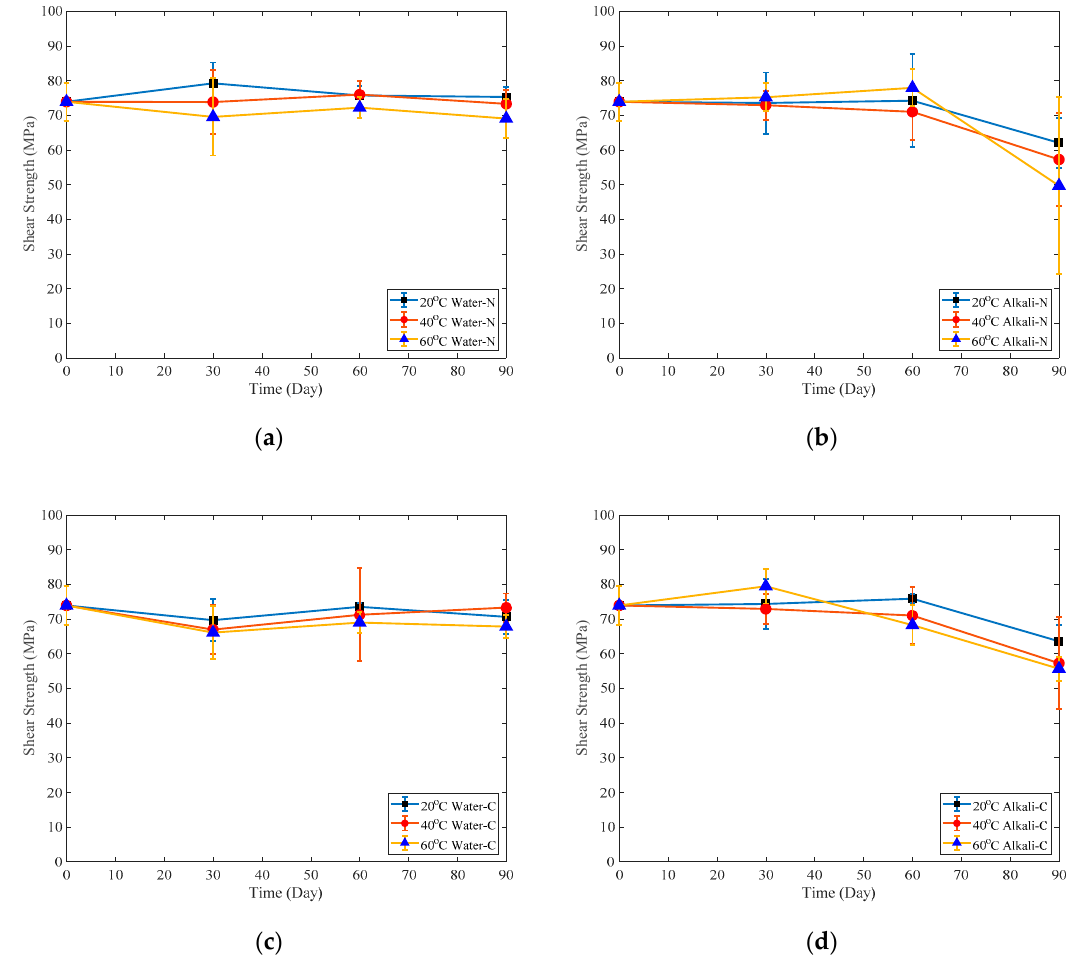
Figure 18. In-Plane shear strength of: ( a ) Naked plate immersed in water; ( b ) Naked plate immersed in alkaline solution; ( c ) Coated plate immersed in water; ( d ) Coated plate immersed in alkaline solution.